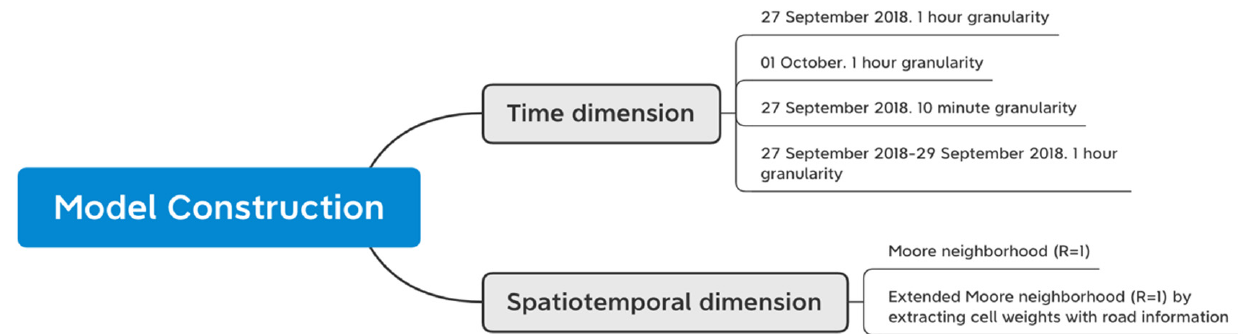
Figure 8. Roadmap of experiments.